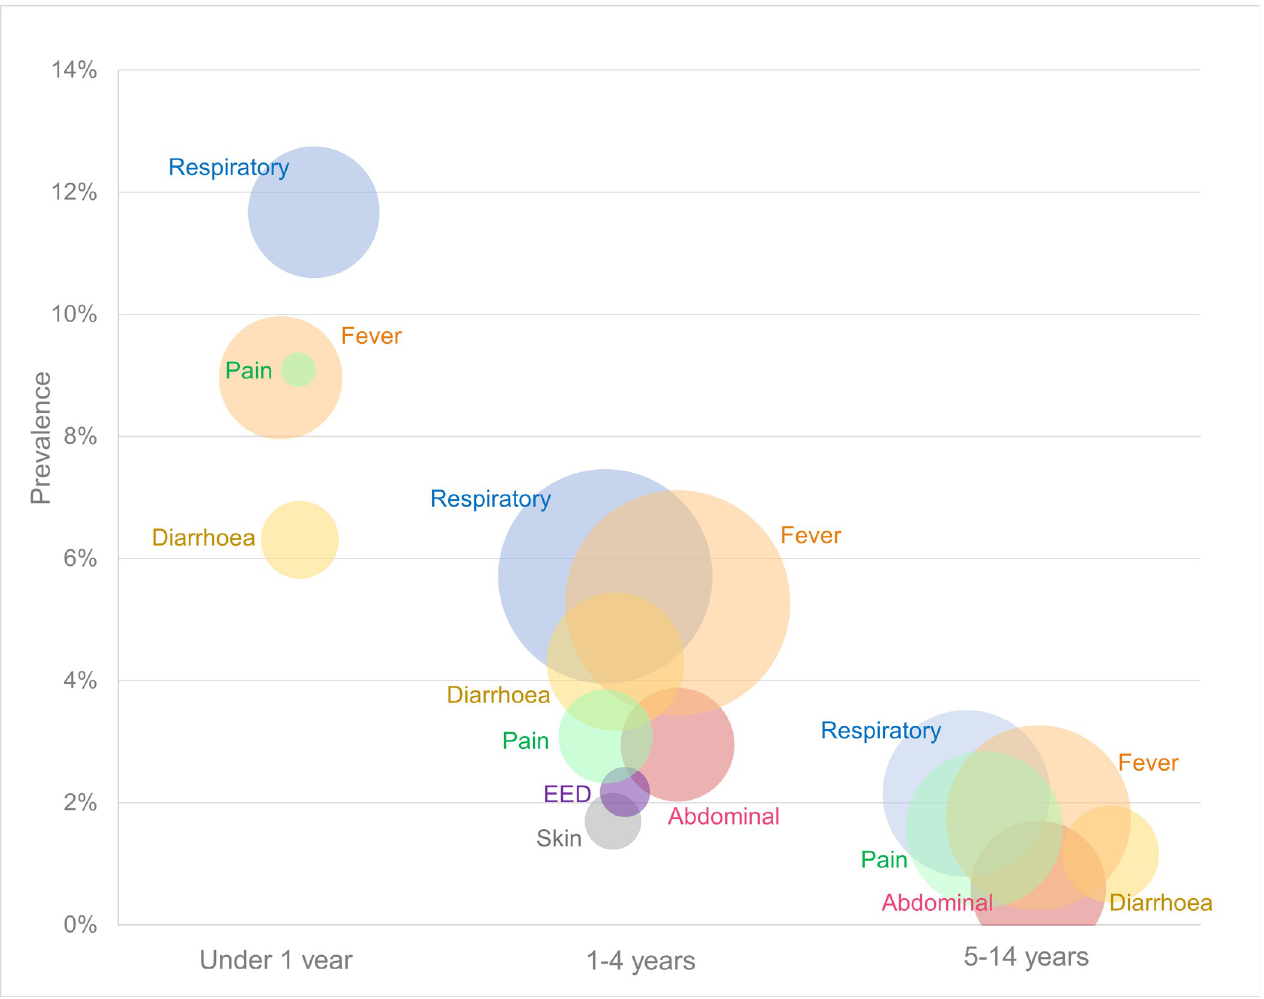
Fig 2. Prevalence of severe or moderate hypoxaemia (SpO 2 < 94%) among acutely unwell children and adolescents presenting to HCIII facilities in Uganda, Feb-Apr 2021, by presenting complaint and age. Notes: Size of bubble represents the number of participants, with hypoxaemia prevalence increasing up the y axis. Categories are not mutually exclusive, with many participants reporting multiple presenting complaints, however the bubble overlap is not necessarily proportional to actual presenting complaint overlap. Presenting complaint categories with less than 5 cases were excluded. EED = eye, ear, or dental